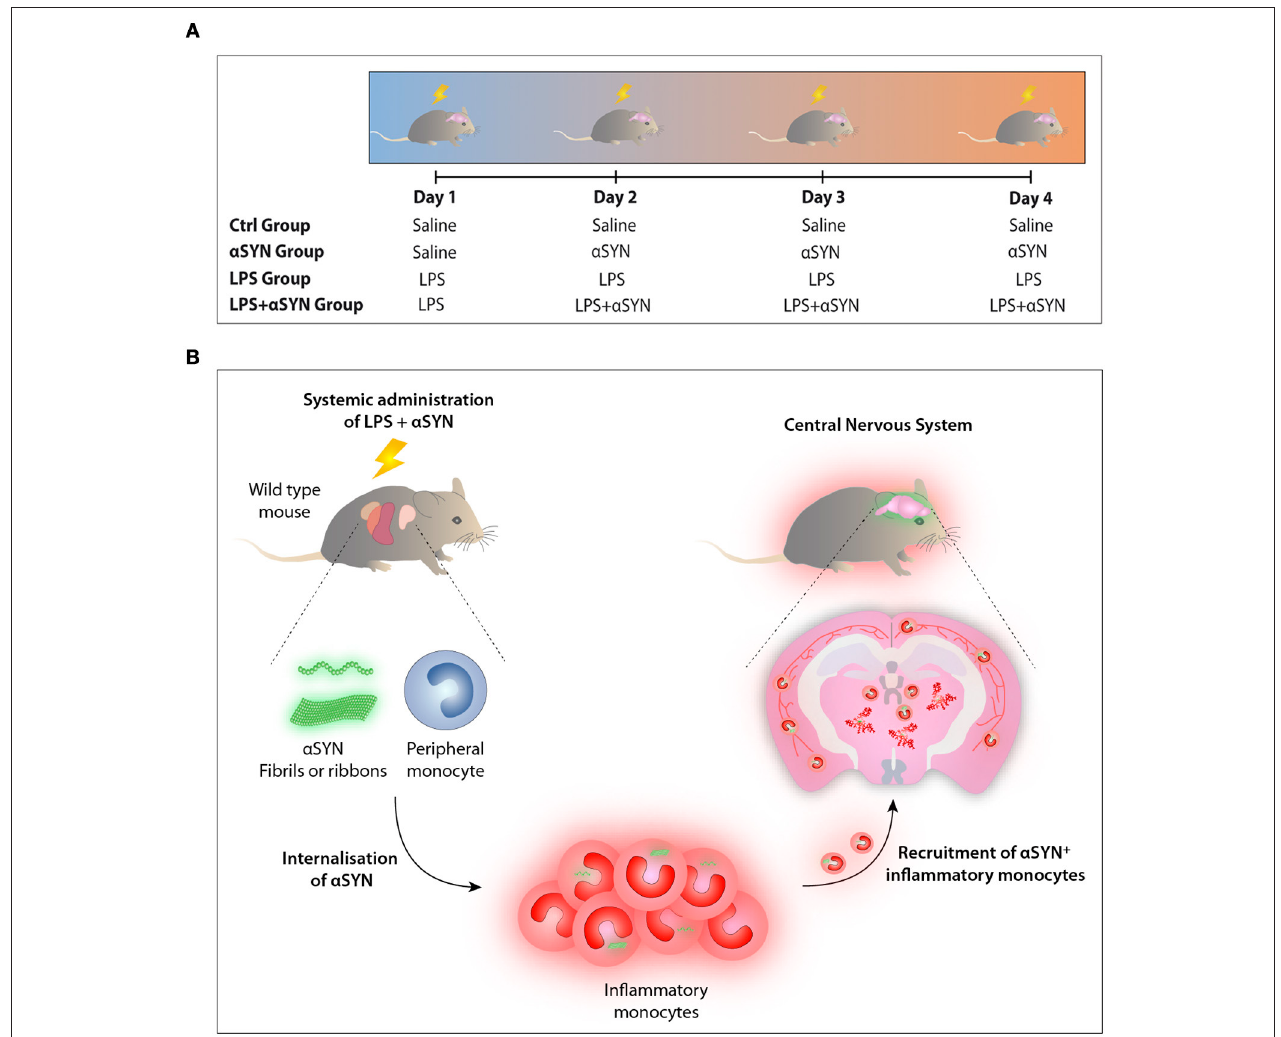
FIGURE 2 | LPS/ α SYN administration scheme. (A) Mice were treated i.p. with 20 µ g of LPS, i.v. with 5 µ g of either two atto-488-labeled pathogenic α SYN strains (fibrils or ribbons), with LPS combined with α SYN as aforementioned, or with saline accordingly and following the administration scheme depicted. Twelve hours after the last injection, mice were euthanised and immune cells were isolated from either whole brain or spinal cord and stained for subsequent flow cytometric analysis. (B) Proposed model: Inflammatory monocytes, from pivotal sentinels to potential Trojan horses driving the dissemination and propagation of α SYN toward the